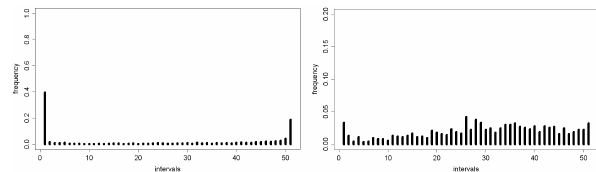
Figure 1 Rank histogram of ensemble wind forecast before (left) and after (right) the recalibration procedure. The frequency of measurements occurrences (Y axis) between the 51 members intervals (X axis) is reported.